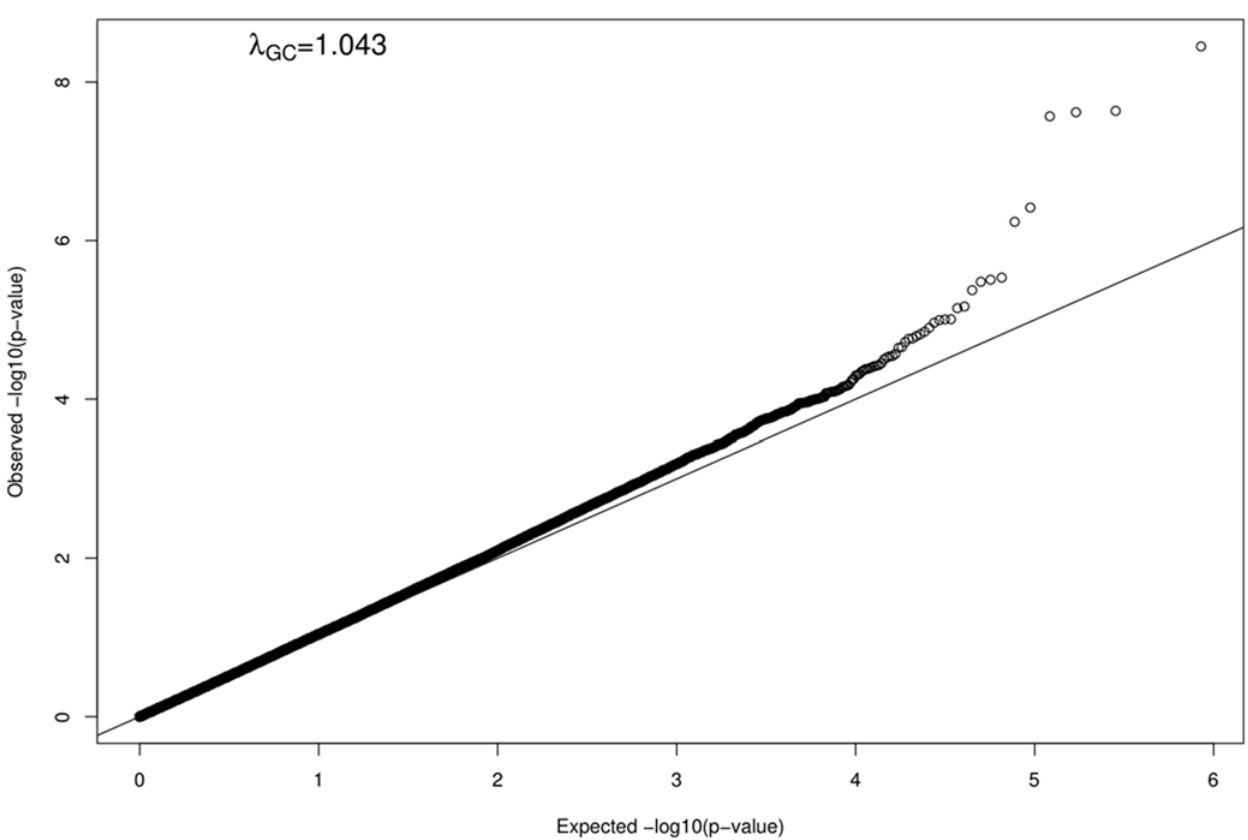
Figure 1. Quantile-Quantile Plot of GWA results for percent predicted FEV 1 /FVC.